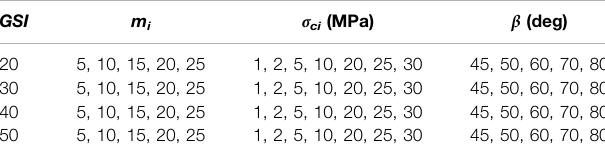
TABLE 2 | Calculation parameters of the HB failure criterion. GSI is geological strength index and m i is rock-type constant.